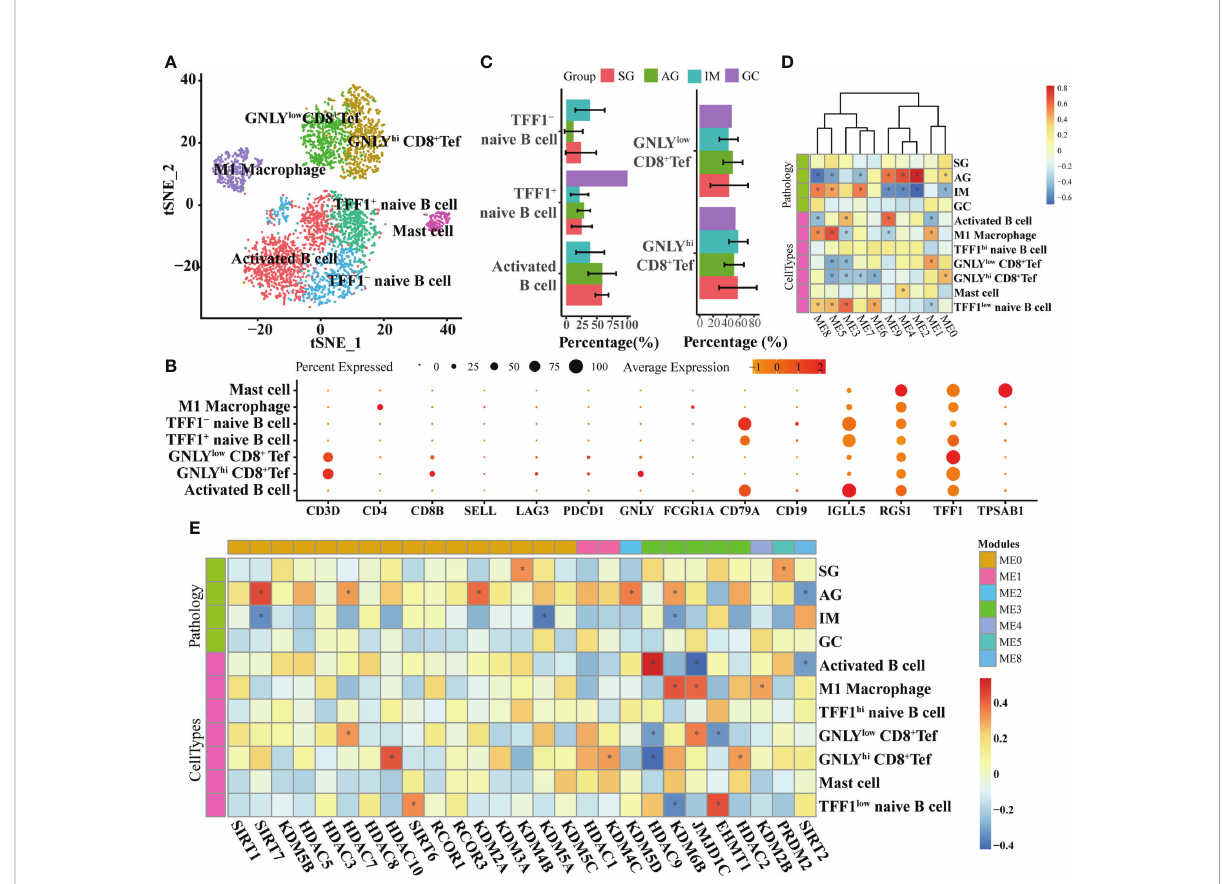
FIGURE 5 WGCNA on immune cells based on scRNA-seq transcriptomes. (A) t-SNE plot visualizing sub-grouped immune cells based on the expression of markers shown in (B) . (C) Bar plot illustrating the percentages of different immune cells in different lesions. Heatmaps illustrating modules – trait relationships (D, E) HMGs – trait relationships. The trait data were composed by lesions and cell types. The module af fi liations of HMGs were labeled by the color bars on the top of the column. The symbol * means FDR adjusted p value for the labeled correlation was less than